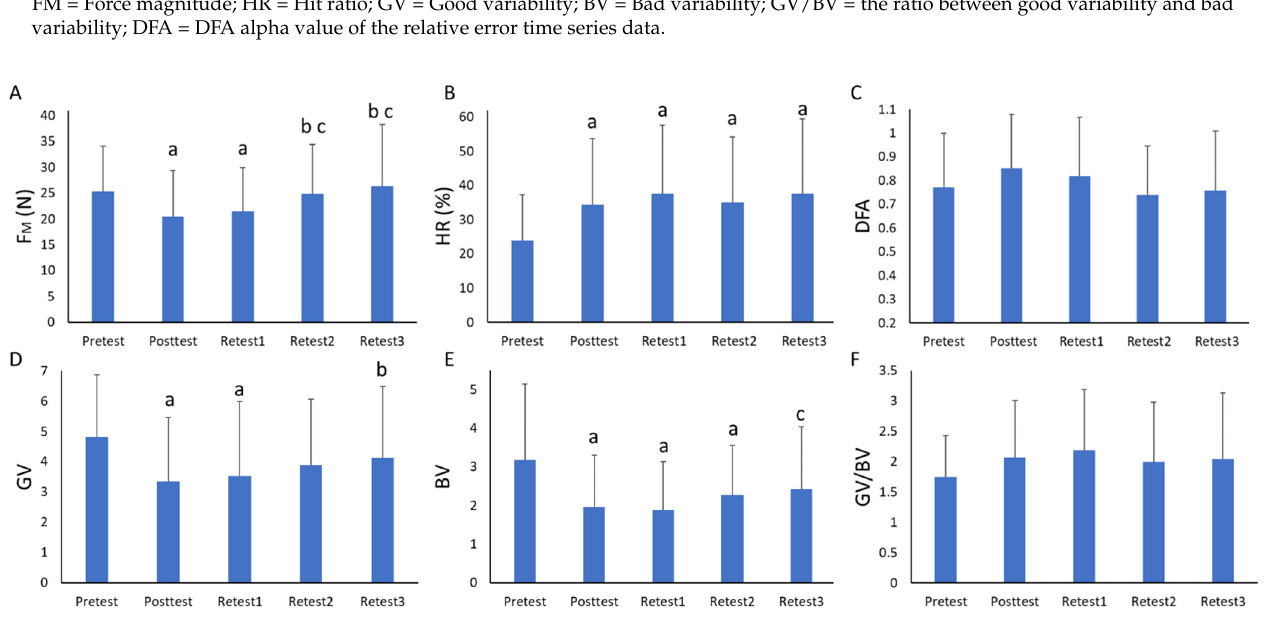
Table 2. Pearson product moment correlation coefficient calculated between initial performance (HRPRE), the learning ratio, and the initial outcomes of the rest of the variables.